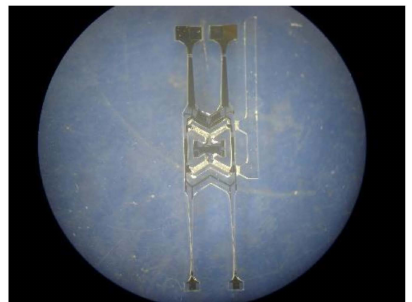
Figure 8. The sensitive unit of the Micro Electronics Mechanical System(MEMS)quartz resonant gyroscope.